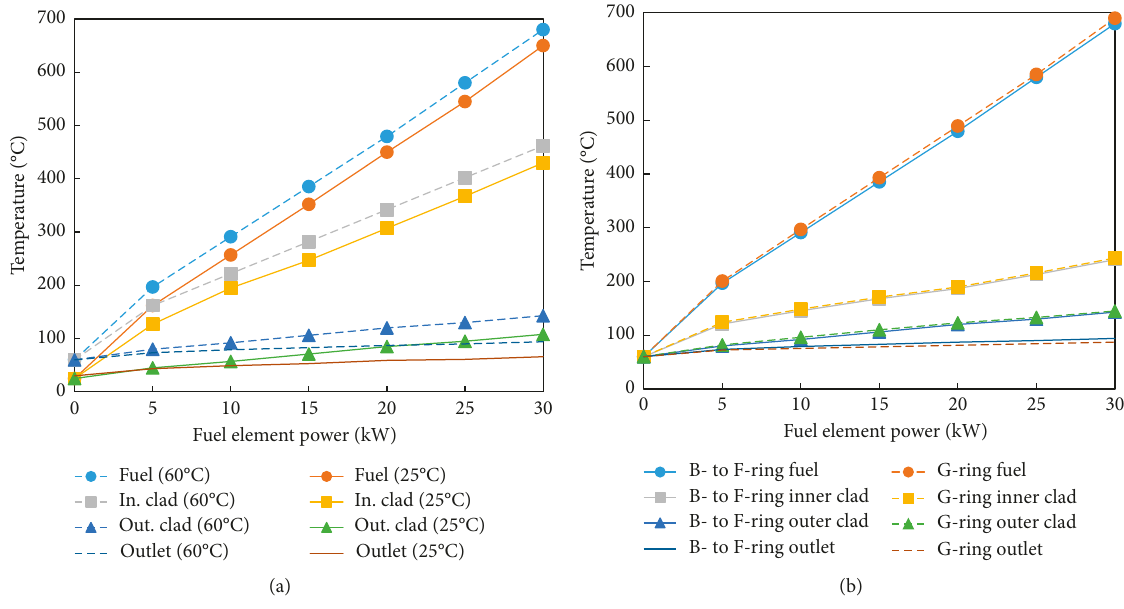
Figure 11: Temperatures versus the fuel element power for (a) each ring and (b) inlet temperatures of 25 ° C and 60 ° C.